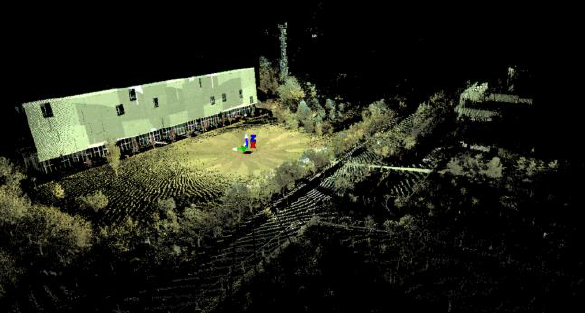
Figure 2: Overview of the day time scan and the area with image overlay